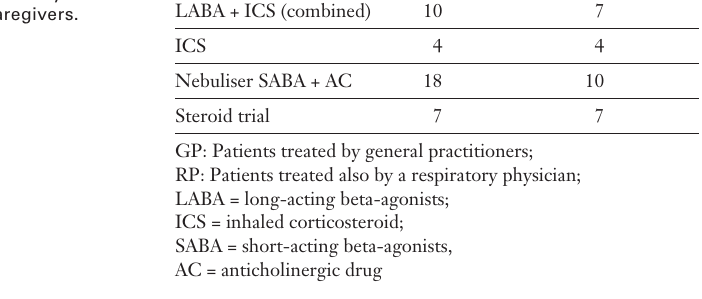
Pharmacological treatment by differ- ent